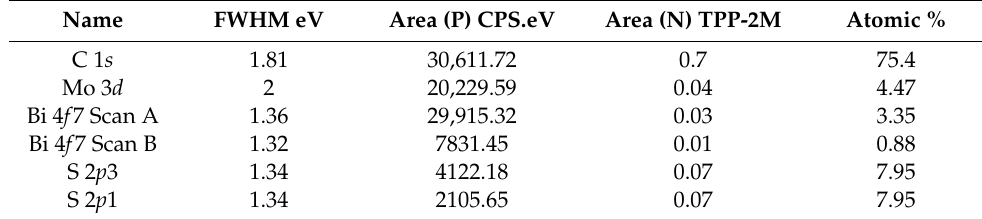
Table 2. X-ray photoelectron spectroscopy (XPS) peaks table.